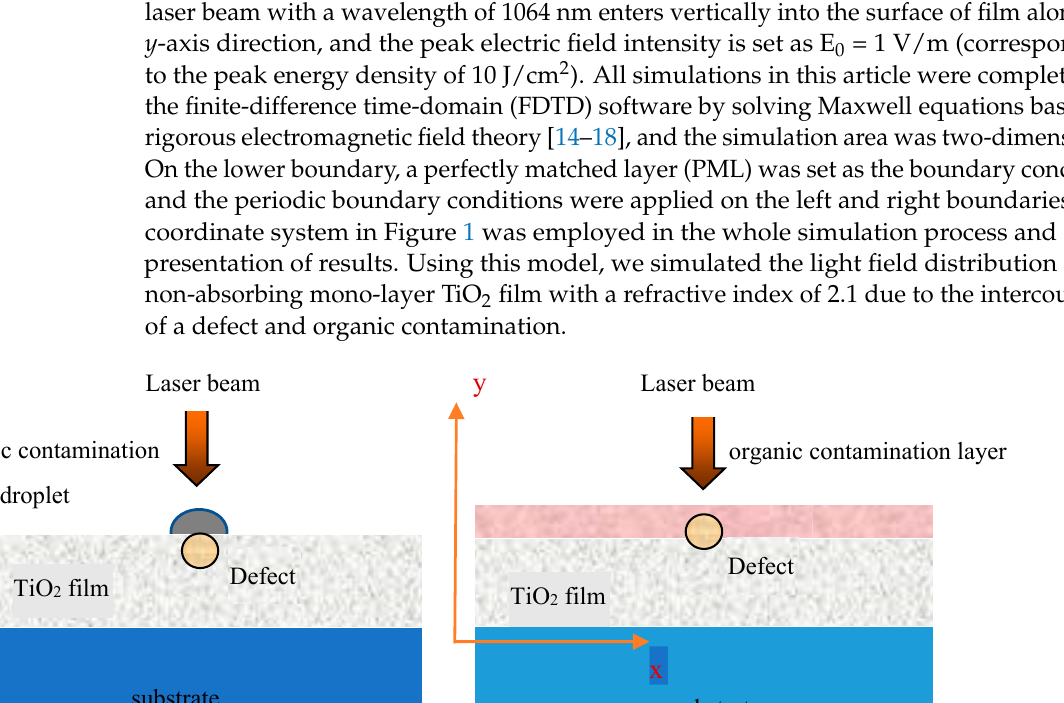
Figure 1. Intercoupling model of defect and organic contamination in the single-layer TiO 2 thin film.